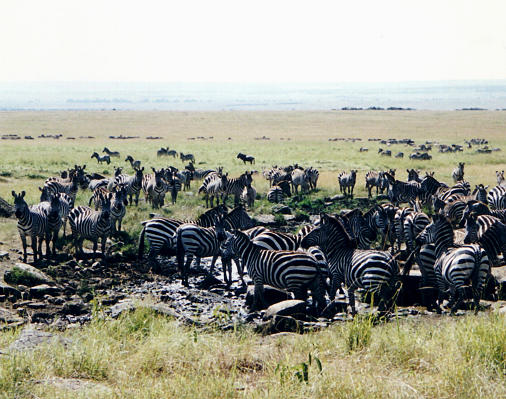
The Masai Mara National Park in KenyaCourtesy of Charlotte Stirling.